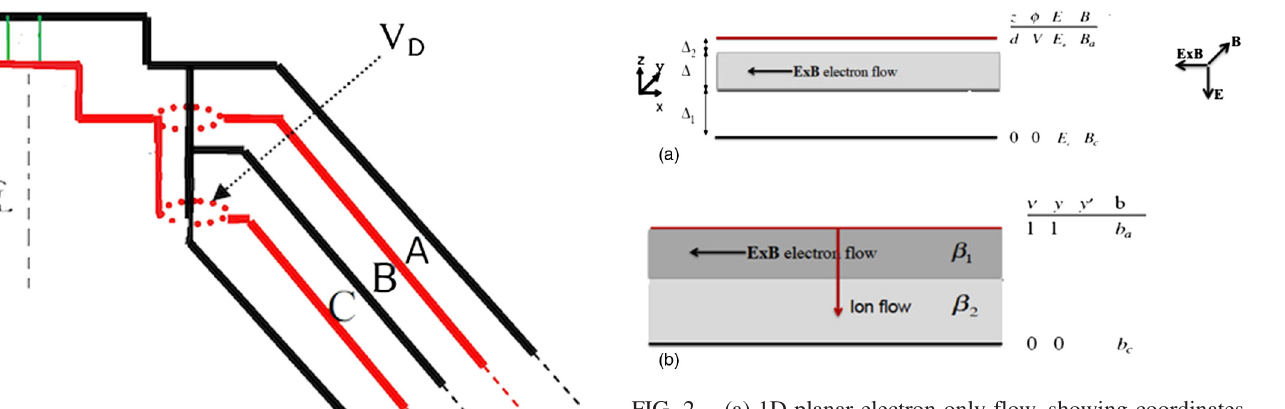
FIG. 2. (a) 1D planar electron only flow, showing coordinates and boundary conditions, as well as the directions of the fields and the electron and power flow direction E × B . (b) Same 1D planar geometry as in (a) for the case of two electron layers, electron and ion crossing the gap, for the model we are considering; see the text for the meaning of the symbols. D